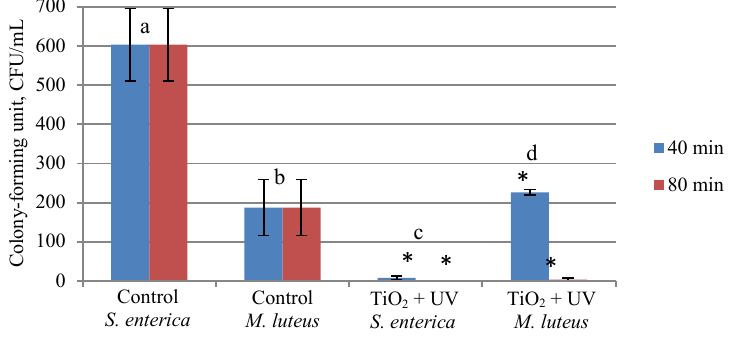
Fig. 9 Viability of S. enterica and M. luteus cells in mixture evaluated by SP method (n=3): a) negative control with none- treated cells; b) effect of TiO 2 ; c) effect of UV; d) effect of TiO 2 + UV. The experiments were performed at 22 °C, the initial amount of bacteria was 2.7×10 6 cfu/mL, dilution factor 1000. 1 mg/mL of TiO 2 was used and the intensity of UV irradiation was 2 mW/cm 2 . *statistically significant difference compared to control group, using one-way ANOVA, p <